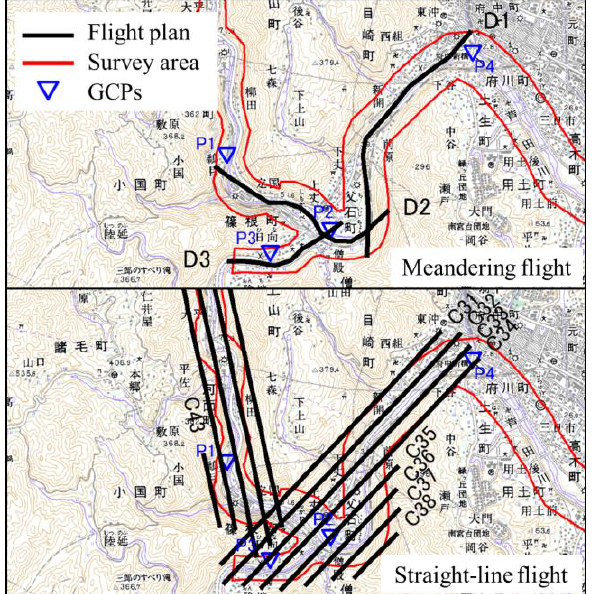
Figure 10. Flight plan of the practical experiment